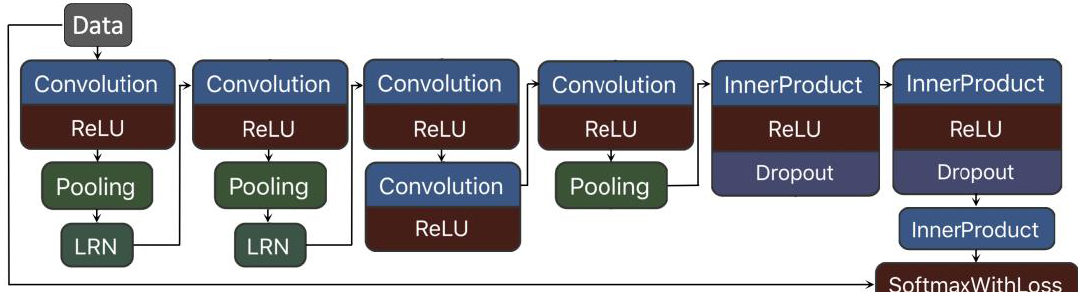
Figure 1. Architecture of the classification model utilized in this study.